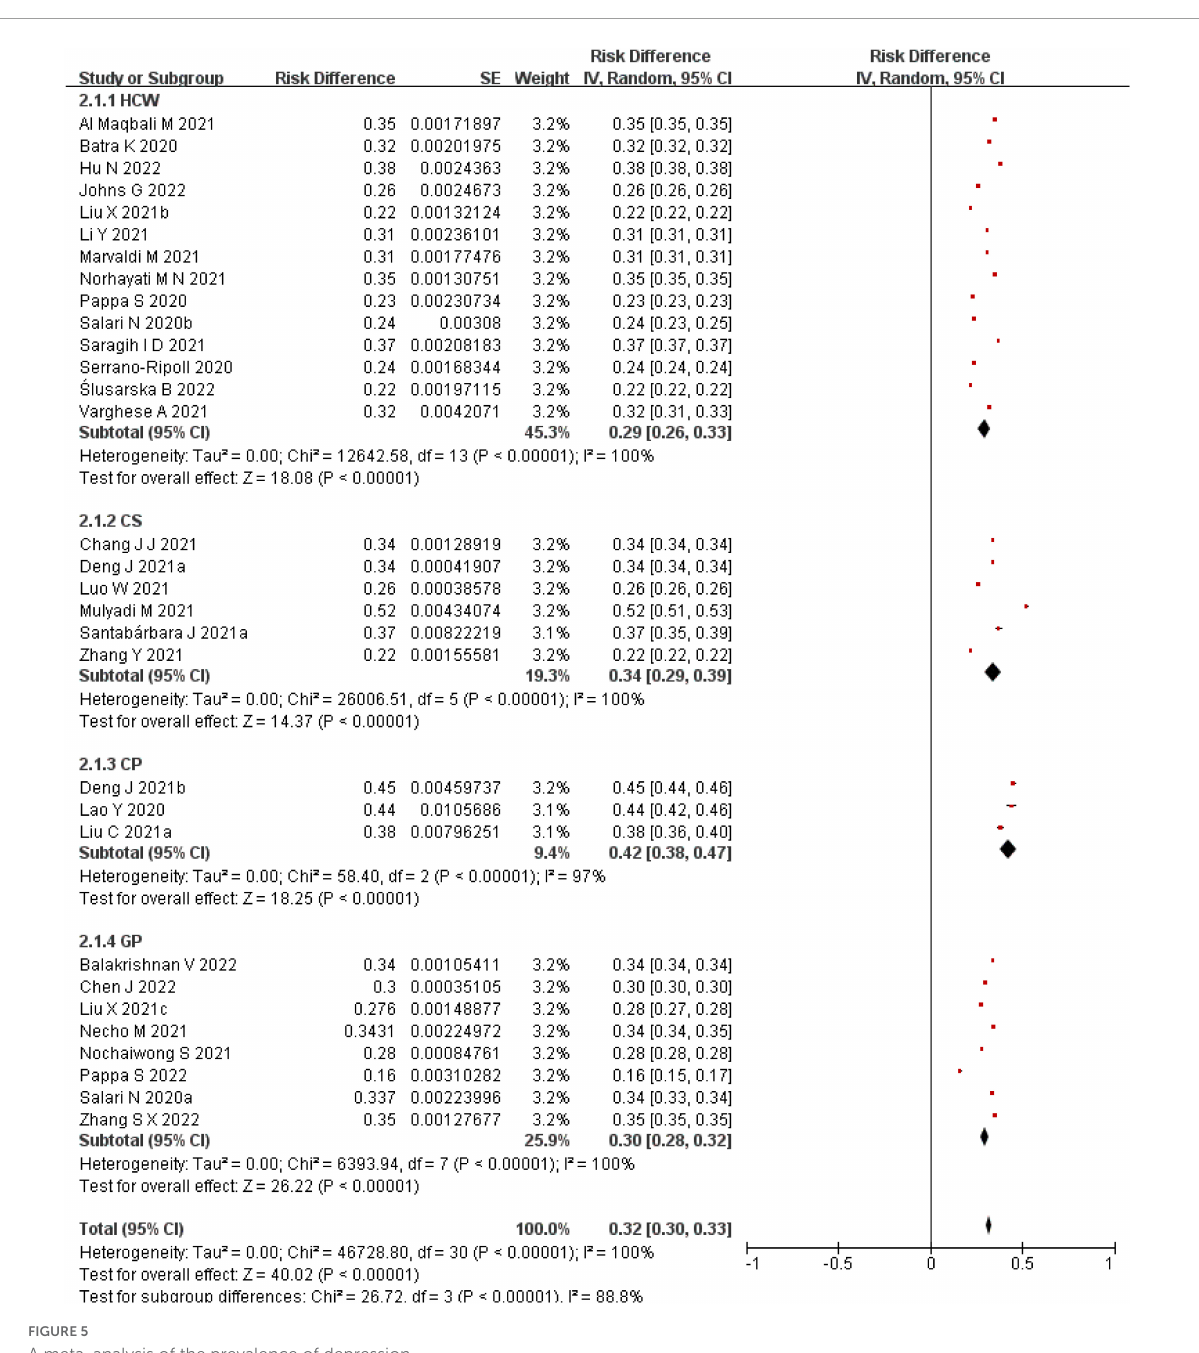
FIGURE5 A meta-analysis of the prevalence of depression.